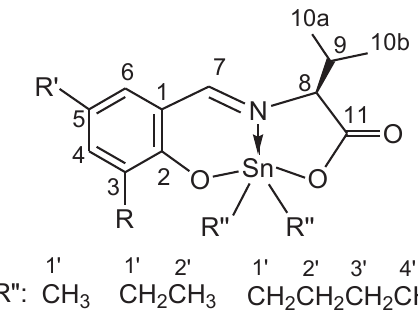
Scheme 2: Numbering scheme for NMR